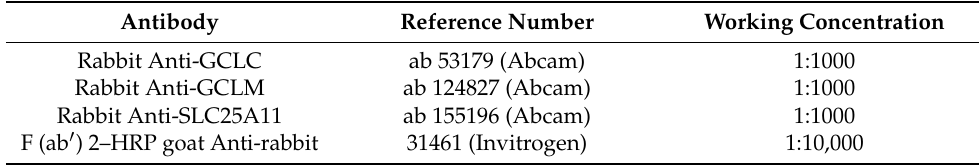
Table 2. Primary and secondary antibodies used in Western blot and working concentration. Antibody Reference Number Working Concentration Rabbit Anti-GCLC ab 53179 (Abcam) 1:1000 Rabbit Anti-GCLM ab 124827 (Abcam) 1:1000 Rabbit